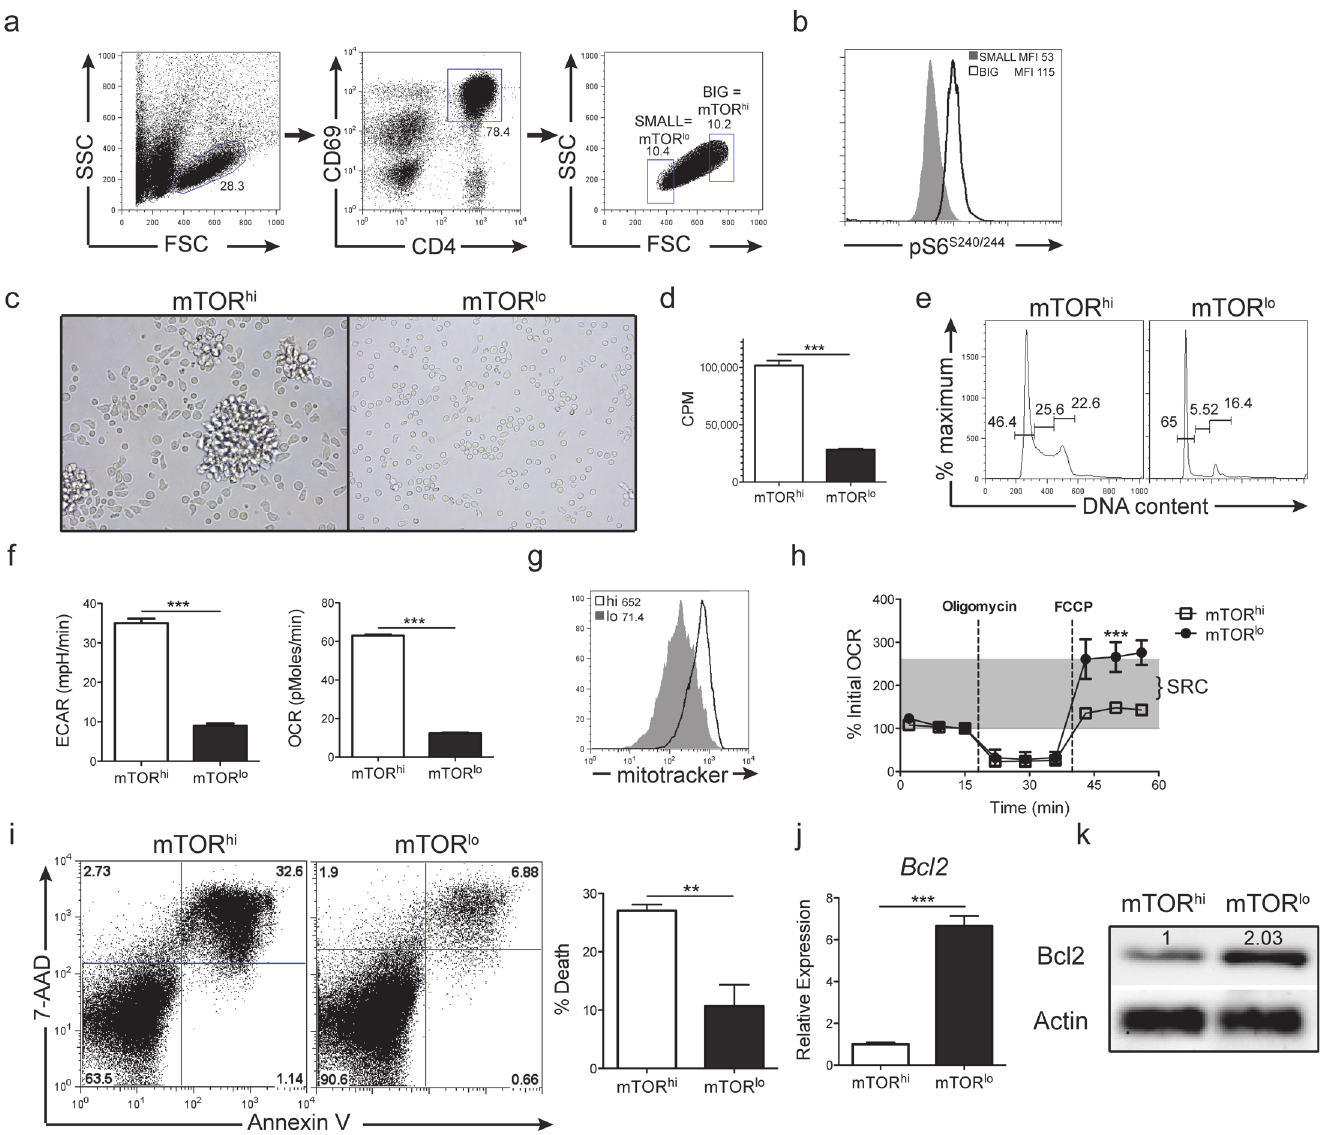
Fig 3. Cell size can be used to isolate recently stimulated CD4+ T cells populations with distinct proliferative, metabolic and survival profiles. a) Splenocytes from 5c.c7 Rag – / — mice were stimulated with 0.5ug/ml PCC peptide for 24hrs then sorted into CD4+CD69+ populations with FSC/SSC “ big ” mTOR hi or FSC/SSC “ small ” mTOR lo profiles. b) mTORC1 activity was assessed from “ Big ” and “ Small ” cells immediately after sorting. pS6 MFI is shown in the upper corner of the plot. c) Sorted mTOR hi cells form large homotypic aggregates when cultured in media containing IL-2 for 4hrs after sorting. d-h) Sorted cells were cultured in media containing IL-2 for 24hrs. d) mTOR hi cells exhibit a higher proliferative rate — as measured by 3 H- thymidine incorporation — than their mTOR lo counterparts. e) Sorted mTOR hi cells show robust cell cycle progression 24hrs post sorting, while sorted mTOR lo cells arrest in the G 0/1 stage. f) mTOR hi cells display a significantly higher Extracellular Acidification Rate (ECAR) and Oxygen Consumption Rate (OCR) than their sorted mTOR lo counterparts. The increased metabolic activity observed in the sorted mTOR hi cells is accompanied by a higher mitochondrial load than sorted mTOR lo cells as indicated by mitotracker green staining ( g ). Mitotracker green MFI shown in upper corner of FACs plot. h ) Sorted mTOR lo CD4+ T cells exhibit a significantly higher Spare Respiratory Capacity (SRC) than sorted mTOR hi cells. i) Sorted mTOR hi cells exhibit a higher rate of cell death when cultured for 5 days in media supplemented with IL-2 than sorted mTOR lo cells. The bar graph to the right depicts